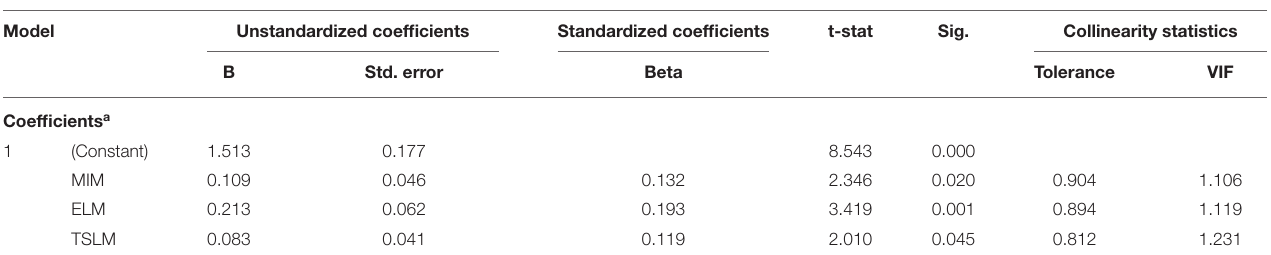
TABLE 6 | Coefficients. Model